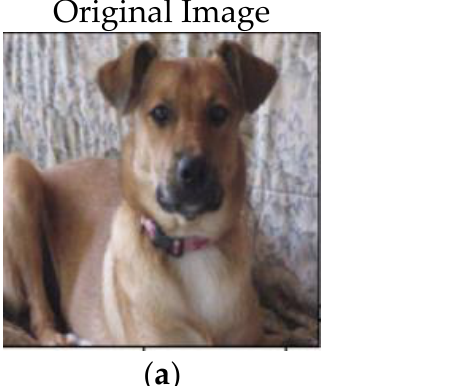
Figure 10. ( a ) Input image; ( b ) output of class activation map (CAM). Figure 11 shows the results of various pre-trained models, such as VGG 16, VGG 19, ResNet 101, and ResNet 152 with the corresponding results of Grad-CAM, Grad-CAM++, bounding box prediction, and proposed method (GradCAM-MLRCNN), which is the bounding box with mask prediction for k -means clustering : (a) various pre-trained models; (b) results of Grad-CAM; (c) results of Grad-CAM++; ( d ) bounding box prediction on Grad-CAM++; and (e) GradCAM-MLRCNN.